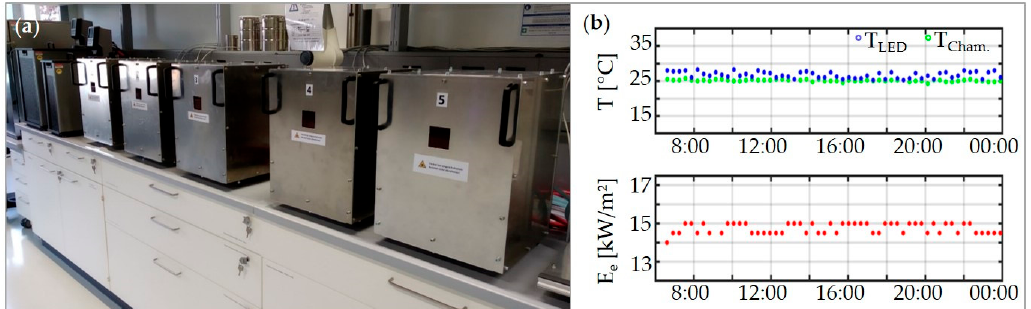
Figure 2. ( a ) Photograph of the enclosures for radiation-protection; and ( b ) exemplary presentation of the MATLAB Plot-Window, showing the temperatures of sample chamber and copper block (top) and the calculated irradiance (from LDR-readouts) on the bottom of the sample chamber (bottom) over a time period of 18 h.